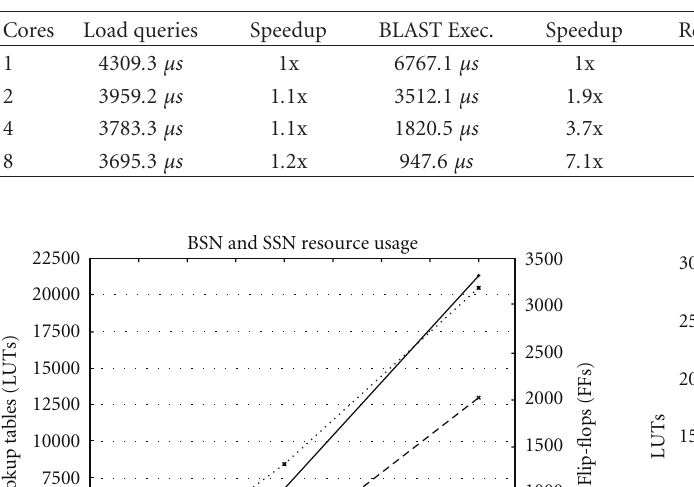
Table 5: Performance of one to eight BLAST cores running in a Microblaze Redsharc system. 100 MHz SSN, BSN, and BLAST Kernel Clocks.